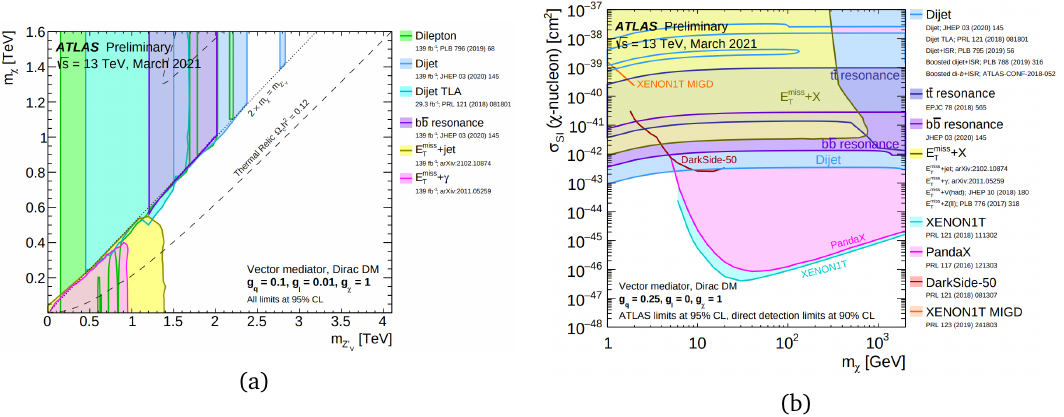
+ X searches for T